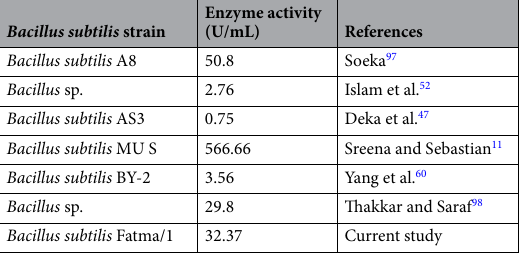
Table 5. Some novel isolated Bacillus strains and their enzyme activity.